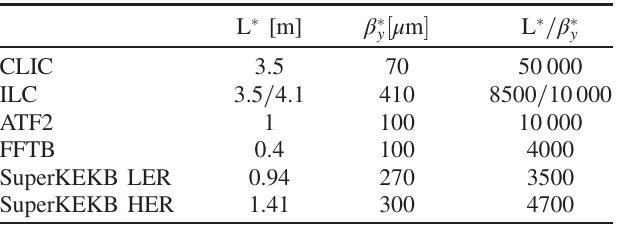
TABLE II. Comparison of chromaticity, ξ y ∼ ð L (cid:1) = β (cid:1) y Þ , in the final focusing quadrupoles for CLIC, ILC, ATF2, FFTB and the Low/High Energy Ring in